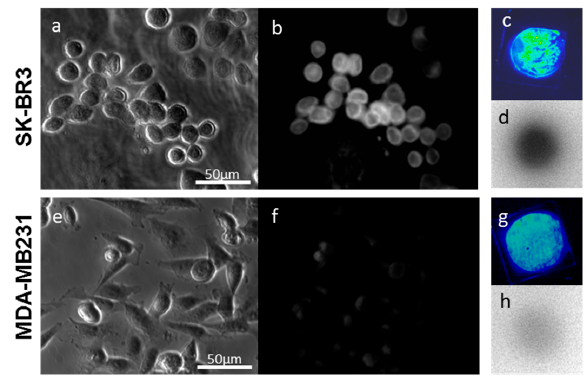
Figure 6. Tumor cell image of dual-imaging probe. SK-BR3 cells ( a – d ) show stronger near-infrared (NIR) fluorescent signals than do MDA-MB231 cells ( e – h ). The increased radioactivity of SK-BR3 cells ( d ) was also confirmed by phosphor imaging. The radioactivity of MDA-MB231 cells is weak ( h ). Cells are shown by phase contrast microscopy ( a , e ).